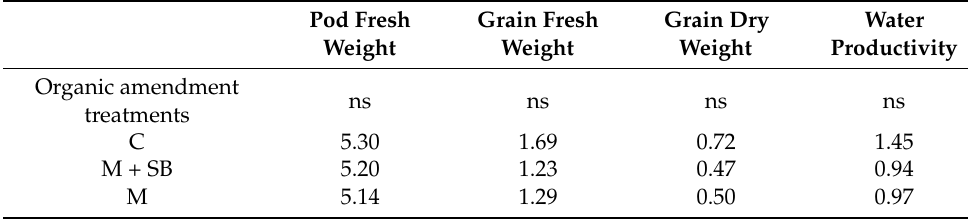
ns denotes not statistically significant